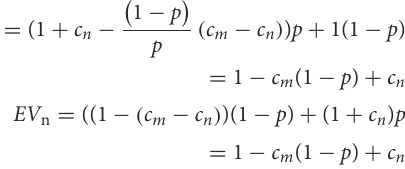
FIGURE6 The fitness lines of migraineurs and non-migraineurs: if d n is in a decreasing situation (d n → d n ′ ), m is increasing (p → p ′ ).